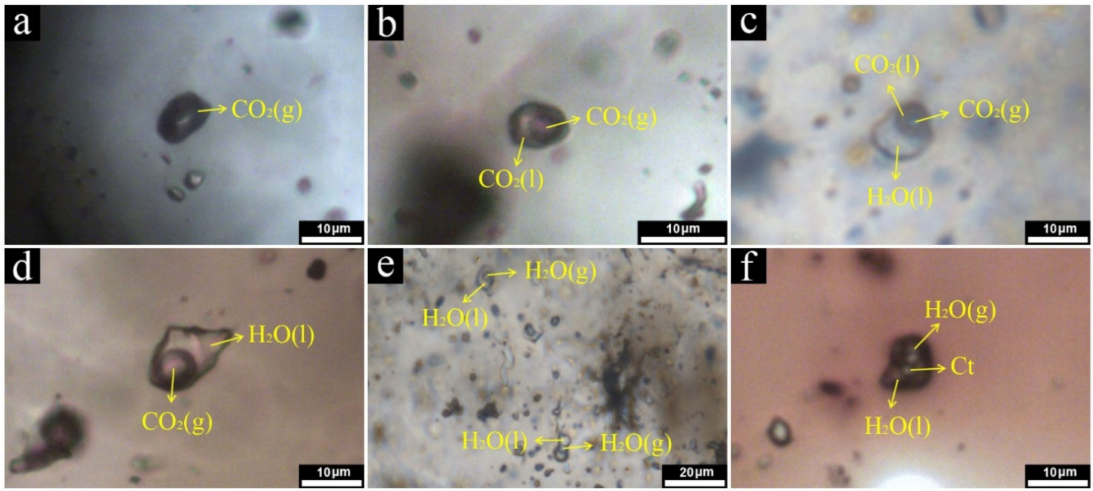
Figure 6. Microphotographs of di ff erent types of fluid inclusion at the Linglong gold deposit. A-type fluid inclusions with monophase CO 2 (G CO2 ) ( a ) and two phases (L CO2 + G CO2 ) ( b ); ( c ) B-type fluid inclusions with three phases (B1-type) (c) and two phases (B2-type) ( d ); ( e ) C1- (the upper) and C2-type (the lower) fluid inclusions; ( f ) D-type fluid